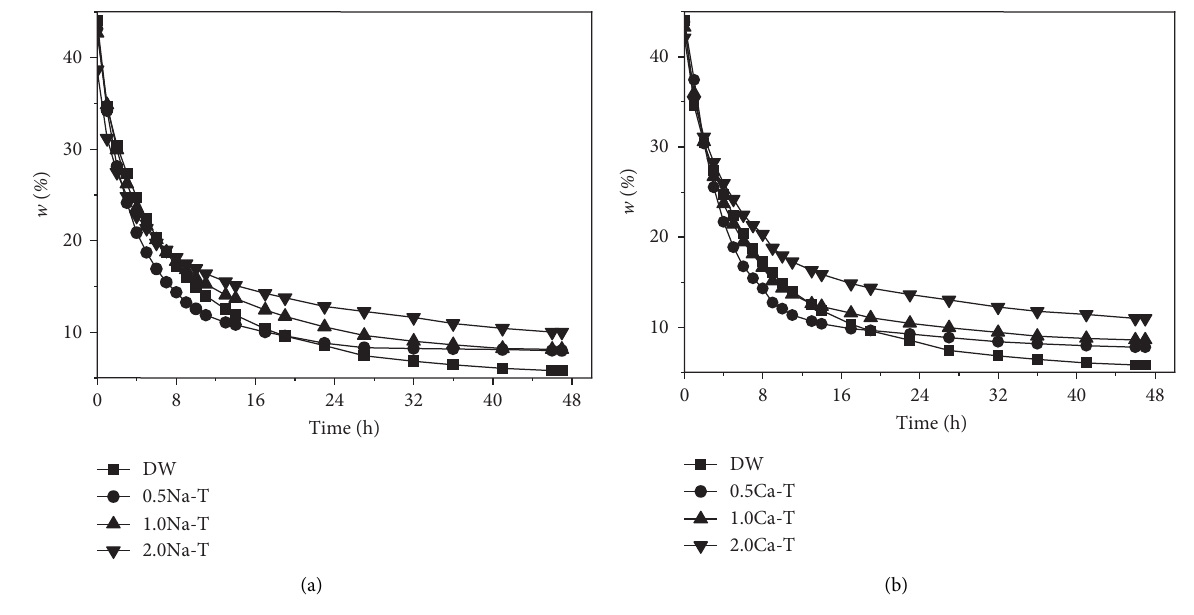
Figure 5: Variation of water content with elapsed drying time. Table 3: Initial and residual water content of